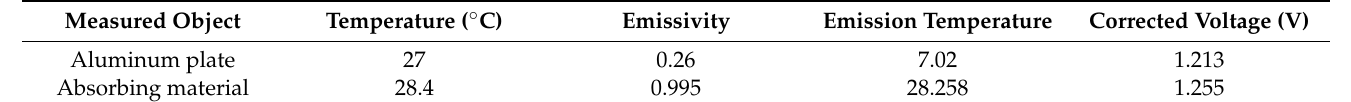
Table 7. Data of aluminum barrel and absorbing material for overall calibration.